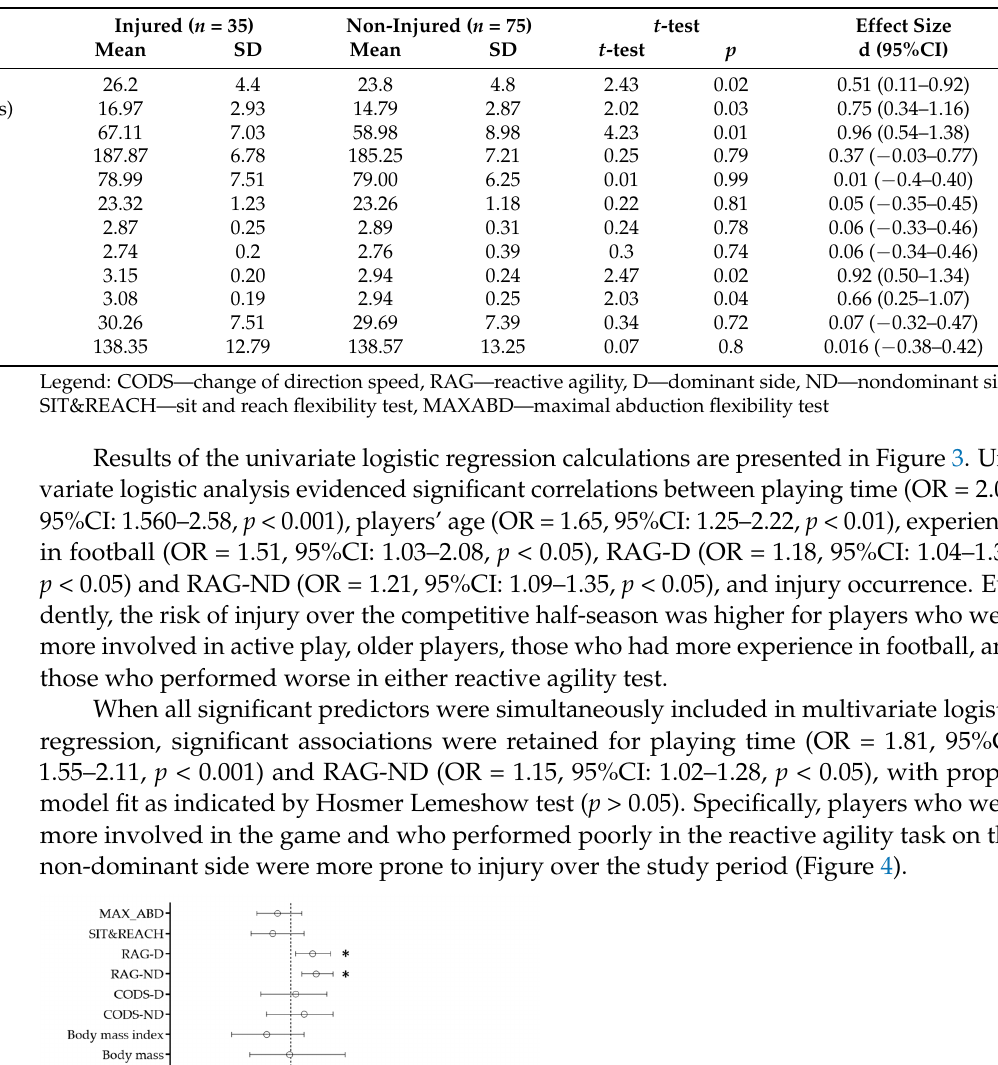
Table 1. Descriptive statistics and differences in study variables between injured and non-insured players.